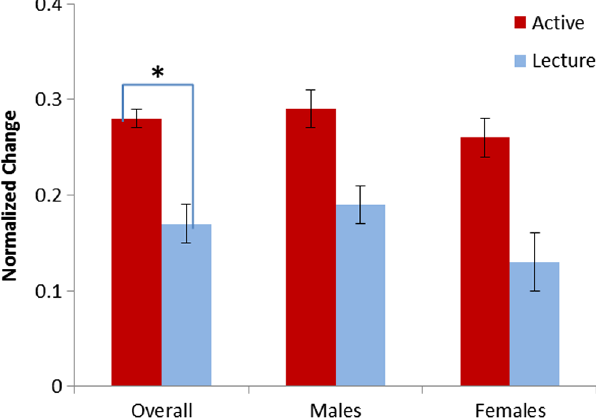
FIG. 1. Normalized change on the FCI across the Fall semester for students in Active Physics and traditional-lecture physics. Error bars represent the standard error of the mean. (cid:1)ð p < 0 . 05 Þ for instruction-type main effect in regression analyses. Signifi- cance tests were not conducted separately within each gender because the gender × instruction-type effect was not significant.